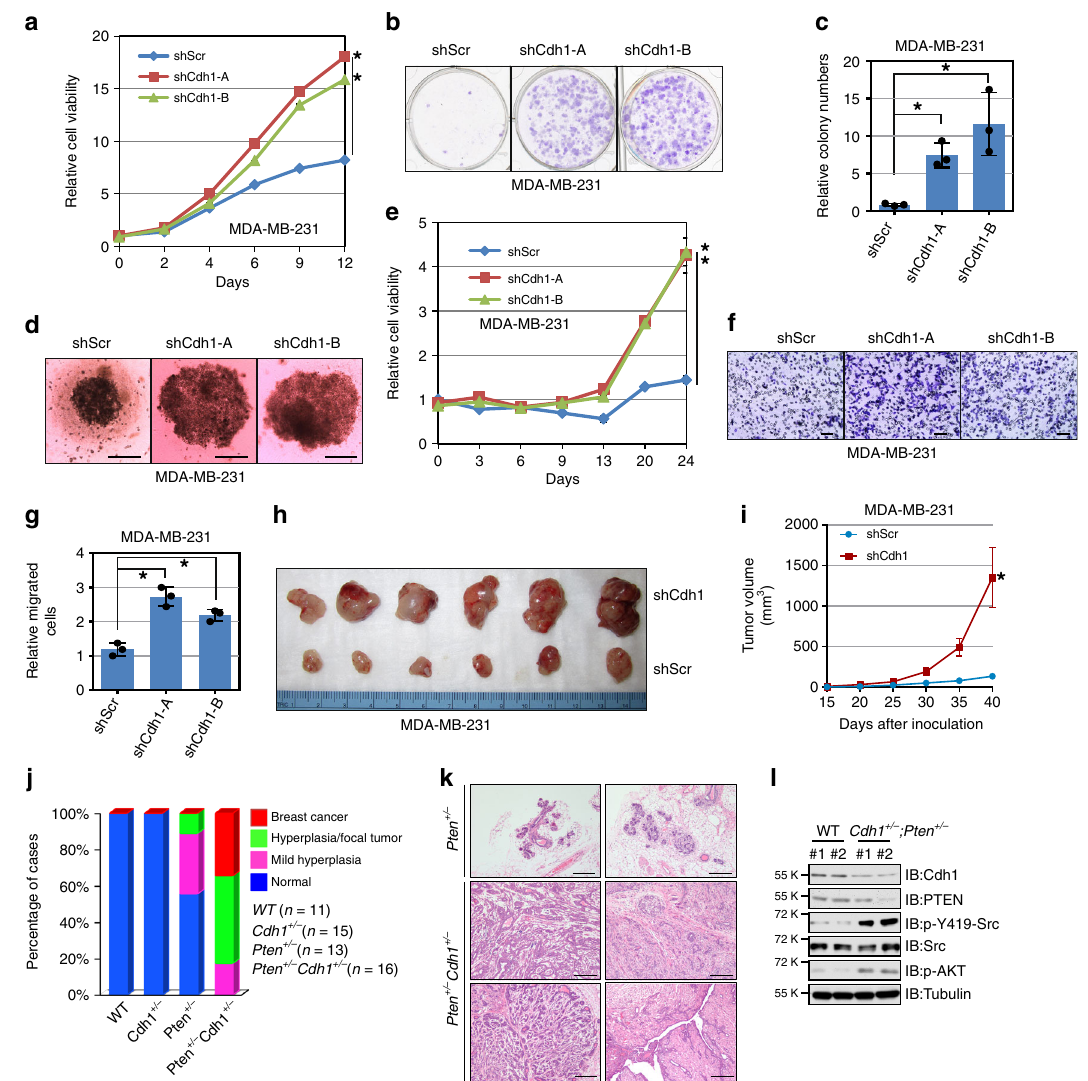
Fig. 2 Cdh1 de fi ciency facilitates breast tumorigenesis. a MDA-MB-231 cells infected with control shRNA (shScr) or sh Cdh1 lentiviral constructs as described in Fig. 1b were subjected to cell proliferation assays in DMEM medium supplemented with 10% FBS for up to 12 days. Relative cell viability was determined at the indicated time points and was calculated as mean ± SD from three independent experiments. * P < 0.05; Student ’ s t test. b , c MDA-MB- 231 cells generated in ( a ) were subjected to clonogenic survival assays in DMEM medium supplemented with 10% FBS for 14 days. Crystal violet was used to stain the formed colonies ( b ) and the colony numbers were calculated as mean ± SD ( n = 3), * P < 0.05; Student ’ s t test ( c ). d , e MDA-MB-231 cells generated in ( a ) were subjected to 3D spheroid formation experiments in DMEM medium supplemented with 10% FBS for 24 days. The representative pictures are shown from three independent experiments ( d ), Scale bar, 100 μ m. Anchorage-independent cell growth was measured using CellTiter-Glo 3D Cell Viability Assay Kit at the indicated time points ( e ). Relative cell viability was calculated as mean ± SD ( n = 3). * P < 0.05; Student ’ s t test ( e ). f , g MDA- MB-231 cells generated in ( a ) were subjected to Transwell migration assays. The representative pictures are shown from three independent experiments. Scale bar, 100 μ m ( f ). The relatively migrated cells were calculated as mean ± SD ( n = 3). * P < 0.05; Student ’ s t test ( g ). h , i Tumor pictures ( h ) and the growth curves ( i ) for the xenograft experiments with the MDA-MB-231 cells generated in ( a ) were inoculated subcutaneously. In each fl ank of six nude mice, 3 × 10 6 cells were injected. The visible tumors were measured at the indicated days. Error bars represent ±SEM ( n = 6) ( i ). j The incidence of mammary gland hyperplasia and tumor in Pten + / − and Pten + / − ;Cdh1 + / − mice (6 – 7 months old) were quanti fi ed. k Hematoxylin and eosin (H&E)-stained sections of mammary tissues isolated from 6-month-old Pten + / − and Pten + / − ;Cdh1 + / − littermates. Scale bar, 100 μ m. l Immunoblot (IB) analysis of lysates from breast tissues of Pten + / − and Pten + / − ;Cdh1 + / −